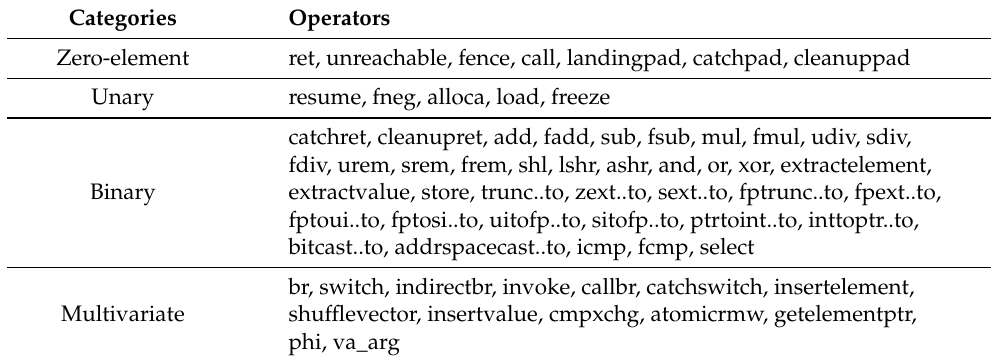
Table 1. Categories of LLVM IR